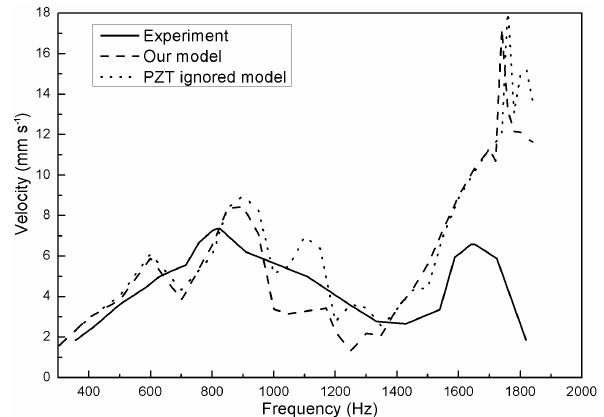
Figure 11. Velocity of the robot versus friction.